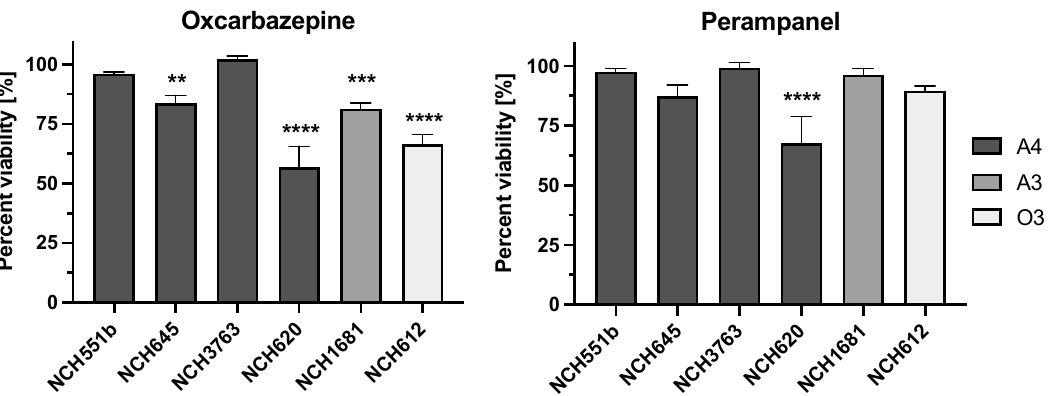
Figure 2. Antiproliferative effect of oxcarbazepine and perampanel at 10 µ M. A significantly lower cell viability upon treatment with oxcarbazepine was observed in four out of the six GSCs compared to the DMSO control. Perampanel induced a significant decrease in viability only in one GSC (NCH620). The experiments were performed in biological and technical triplicates. A4 = astrocytoma WHO grade 4; A3 = astrocytoma WHO grade 3; O3 = oligodendroglioma WHO grade 3; ** p ≤ 0.05; *** p ≤ 0.001; **** p ≤ 0.0001.